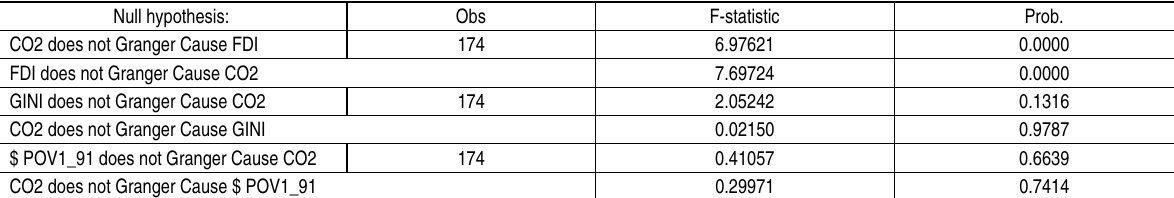
Table 9. The causality test for variable